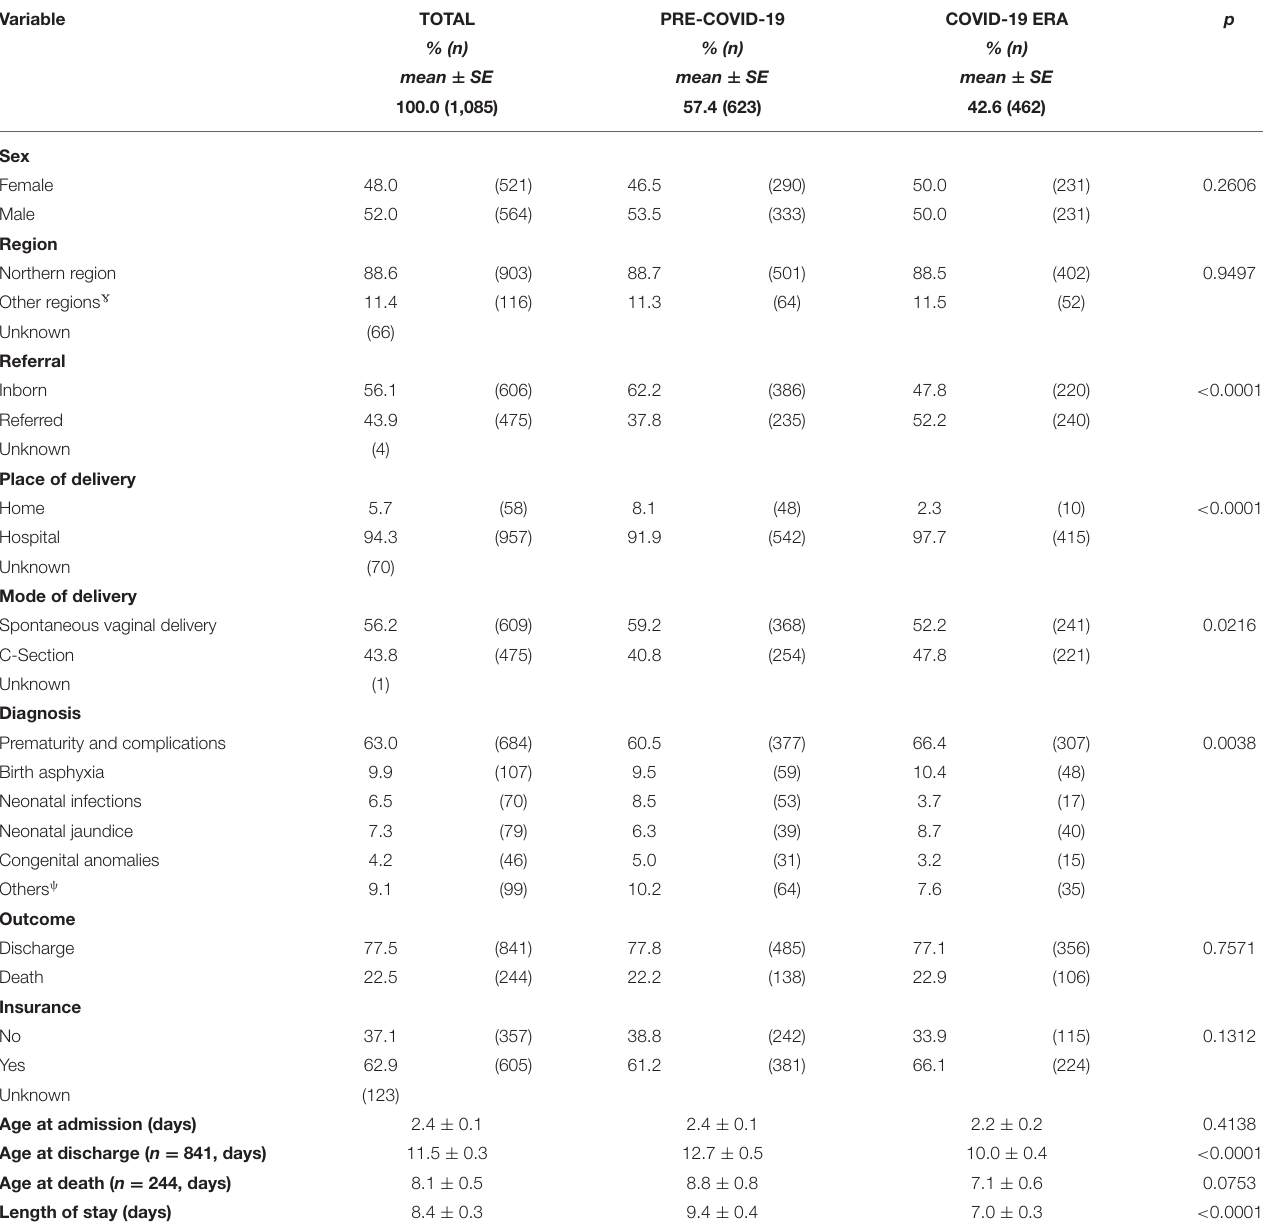
TABLE 2 | General characteristics of LBW neonates ( < 2500g) admitted at TTH NICU during pre-COVID-19 and COVID-19